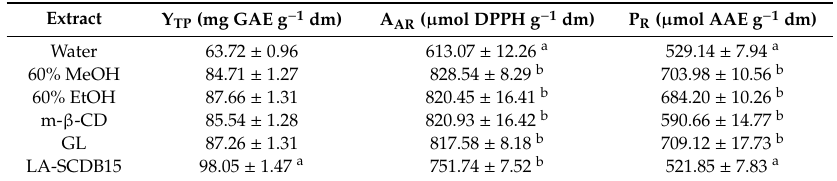
Table 4. Comparative assessment of S. fruticosa extracts produced with LA-SCDB15 and other green solvents. Values given represent means ± standard deviation.